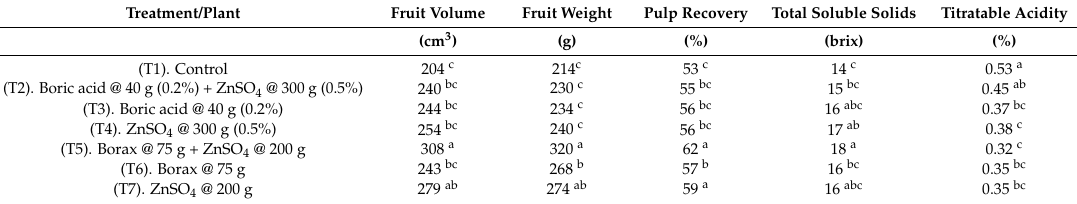
Table 2. Effect of experimental treatments on mean yield and quality traits of mango fruit (cv. Chaunsa white) *.